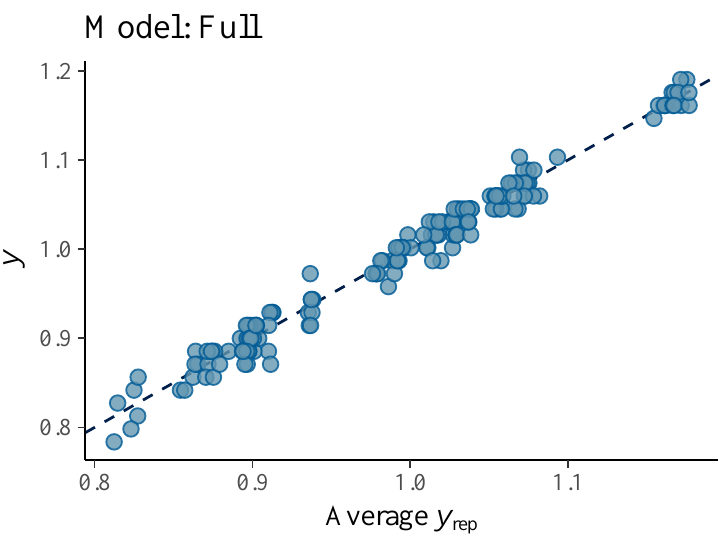
Figure 6. Ball velocity observations (dots) vs. average simulated value of the ball velocity (line) from the posterior predictive distribution of the Full model. This graphical representation suggests that Full model is a good fit to collected data.